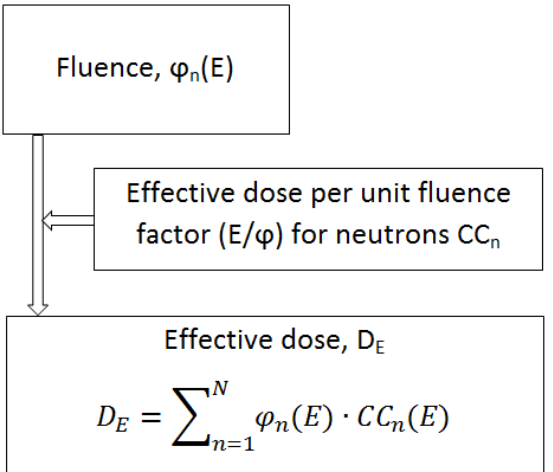
Figure 2. The model of effective dose calculation used in this paper. N – number of neutron energy groups, D E – effective dose, E – neutron